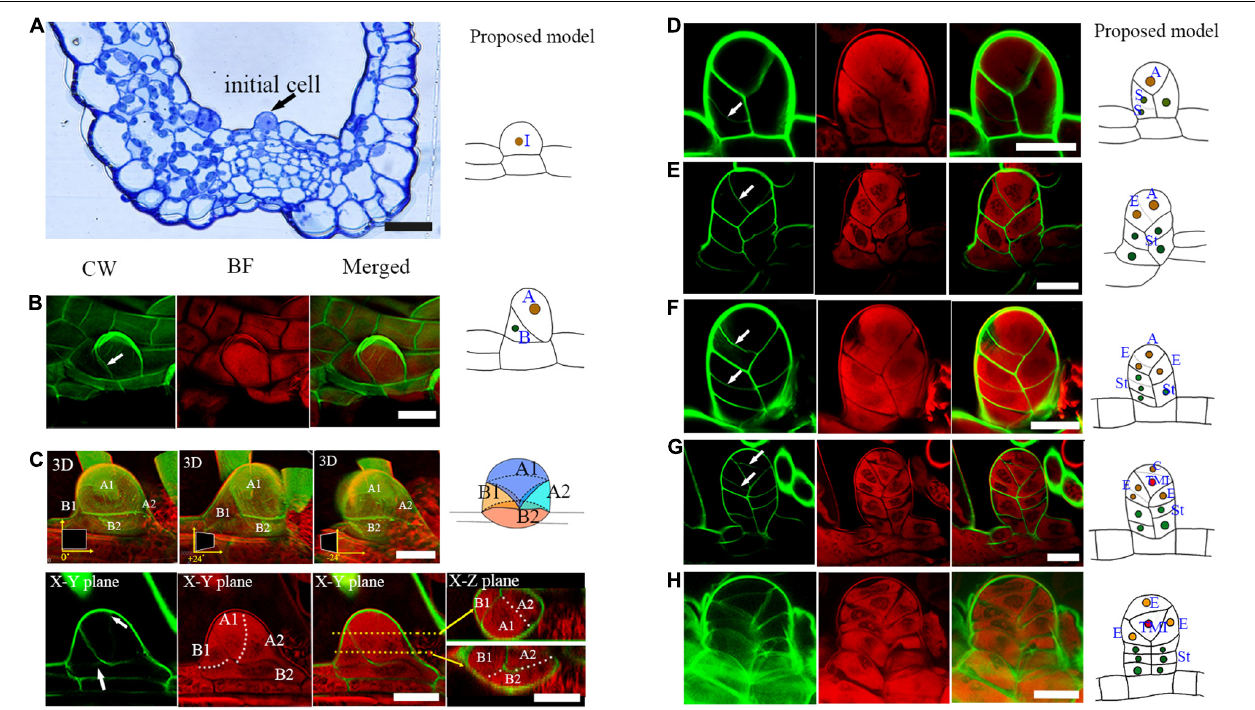
FIGURE 2 | Several rounds of asymmetric cell division initiate early sporangium development. (A) Semi-thin section stained with toluidine blue shows a sporangial initial cell (indicated by an arrow). (B) A sporangial initial cell under asymmetric division. Arrow points to the cell wall (C) . The sporangium consists of four cells. The 3D diagram shows three rotations of 0 degrees, positive 24 degrees, and negative 24 degrees, respectively. The upper arrow points to the newly forming cell wall between the apical cell, the lower arrow points to the newly forming cell wall between the basal cell of the CW staining photo. The two white dotted lines represent the cell walls that will be formed. The two orange dotted lines represent two X-Z planes which are indicated with the two orange arrows. (D) Basal cells performed transverse division which formed the sporangial stalk. Arrow points to the newly formed cell wall. (E) The apical cell formed a new stalk cell. Arrow points to the newly formed cell wall. (F) The apical cell formed an epidermis cell and a new apical cell through oblique divisions. Arrows point to the newly formed cell wall. (F) An epidermis cell formed a stalk cell. Arrows point to the newly formed cell wall. (H) The tetrahedral mother initial cell formed. CW signals are colored green. BF signals are colored red. Scale bar = 20 µ m. (A–H) Proposed models are shown on the right of each inset. (A) , the apical cell; (A1, A2) , the daughter cells of the apical cell. (A1) , the new apical cell; (A2) , the third basal cell; TMI, the tetrahedral mother initial cell; (B) , basal cell; (B1, B2) , the daughter cells of basal cell; (C) , the cap cell; (E) , the epidermis cell; I, the initial cell; St, the stalk cell; 3D,